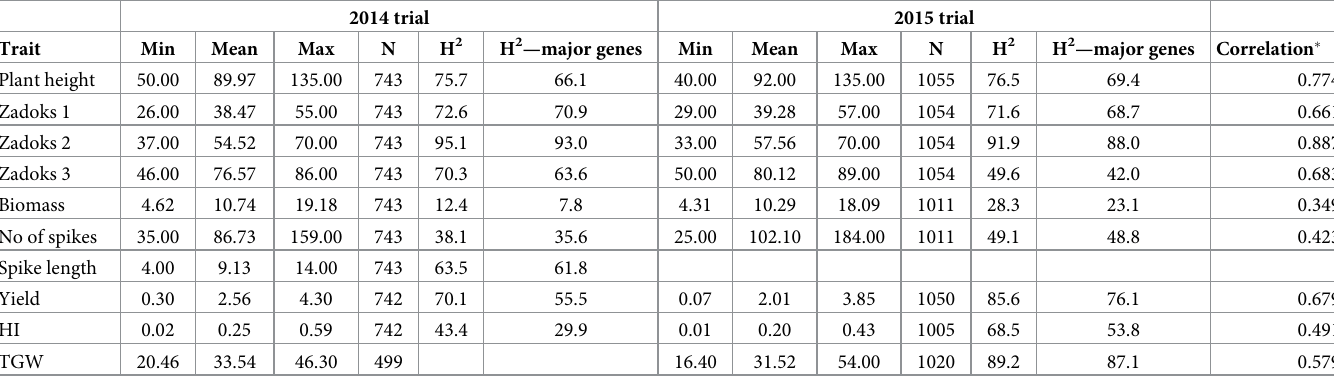
Table 1. Descriptive statistics of the wheat diversity panel in field